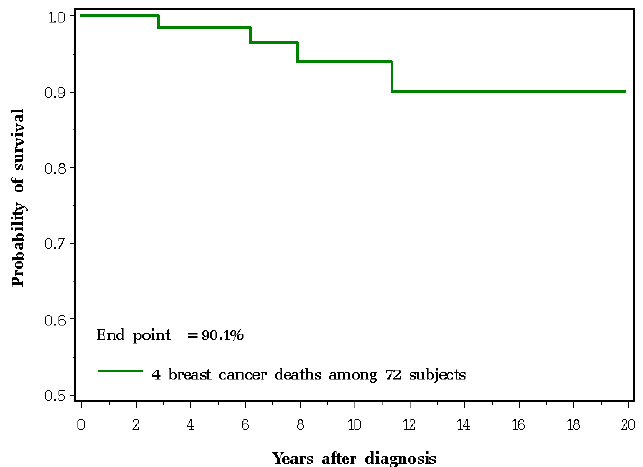
Figure 2. Twenty-year breast cancer-specific survival for 72 patients with invasive breast cancer.